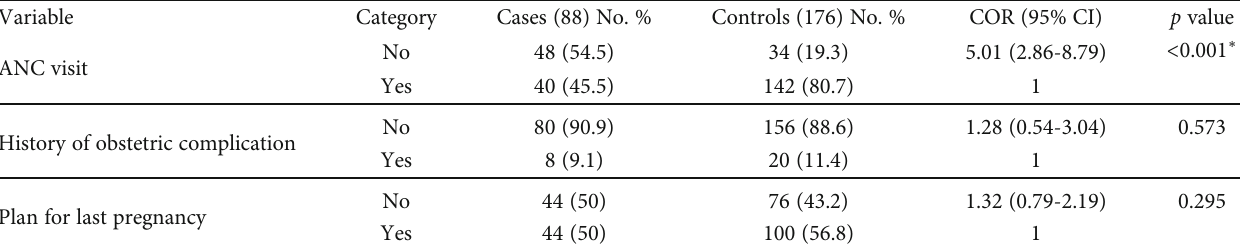
Table 4: Bivariate analysis of need-based factors of cases and controls in Abobo Woreda, Gambella region, Southwest Ethiopia, 2019. Variable Category